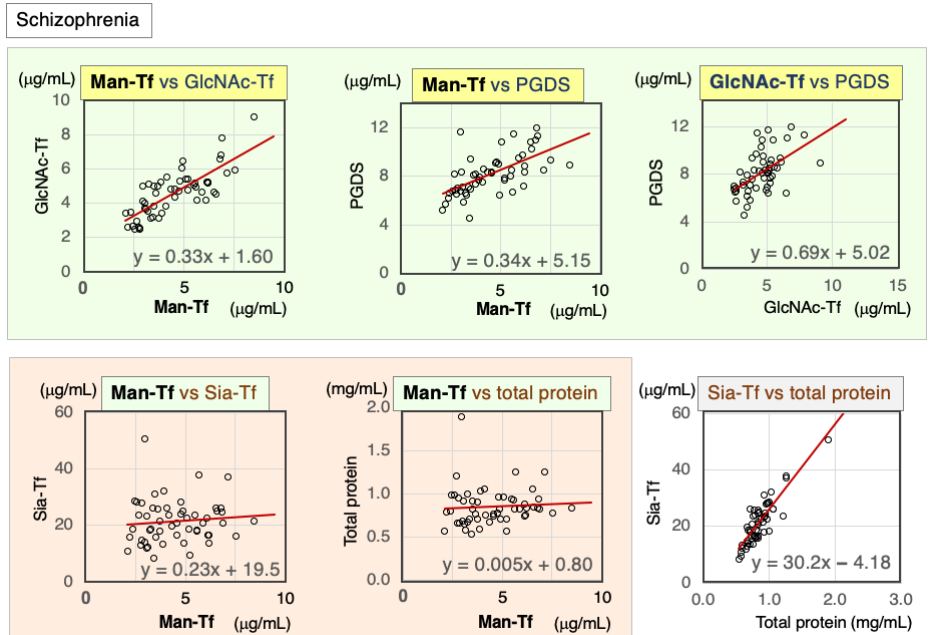
Figure 3. Scatter diagrams and regression lines of marker combinations in the CSF of schizophrenia patients. Table 2. Correlation coefficients of markers in CSF of schizophrenia patients.